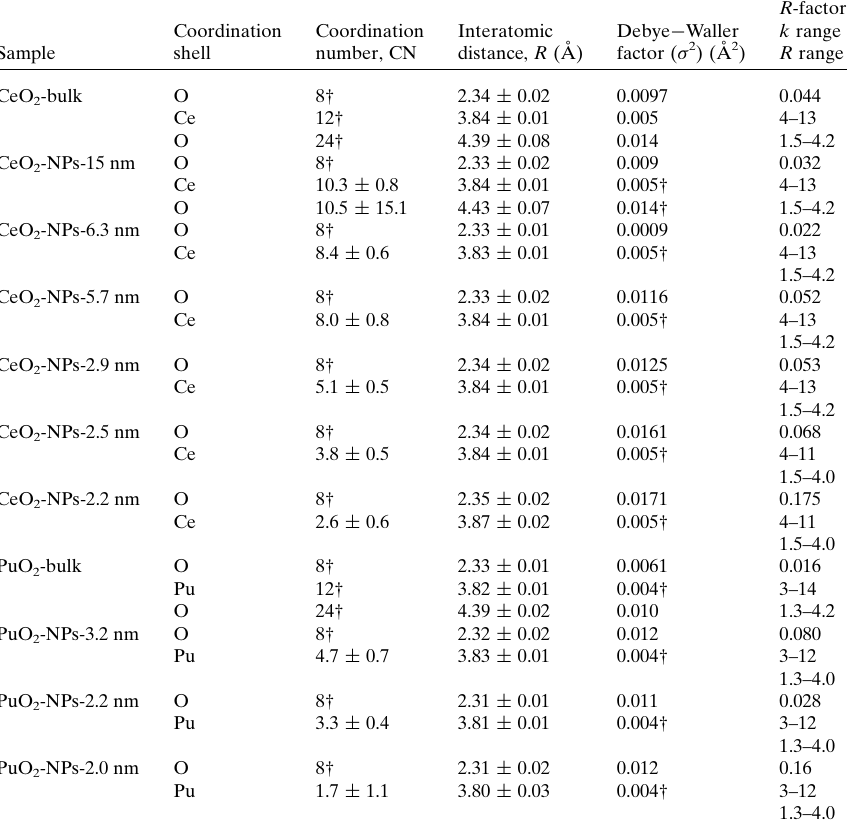
Table 2 Structural parameters obtained from the fitting of EXAFS